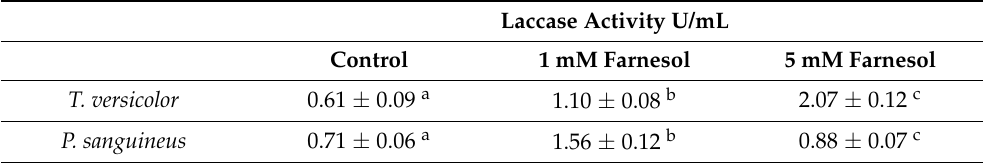
Values labeled with the same letter in each line are not statistically different ( p > 0.05).